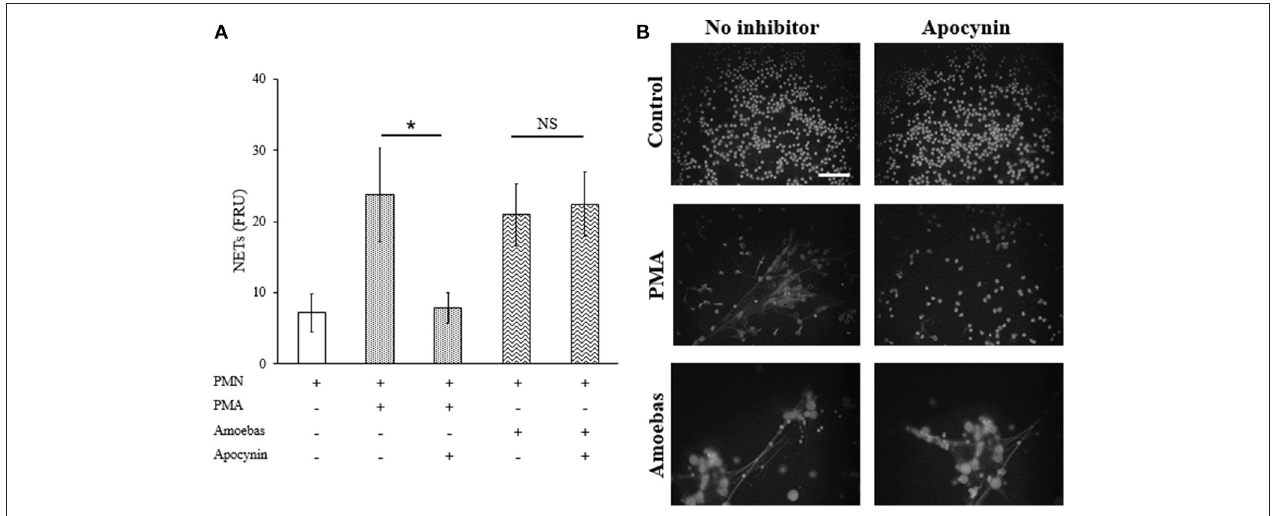
FIGURE 7 | NETosis induced by trophozoites is independent of NOX2-derived ROS. (A) Neutrophils (3 × 10 5 ) were pre-incubated with 200 µ M apocynin or DMSO for 30min and then stimulated with 20nM PMA or co-cultured with trophozoites (1.5 × 10 4 ) during 4h. Supernatants were collected, mixed 1:1 with SYTOX Green (500nM) and fluorescence was measured. NETs amount is expressed in fluorescence relative units (FRU). Values are means ± SD of three independent experiments in triplicate. * p < 0.001; NS: statistically non-significant. (B) Neutrophils were treated as describe previously, cells were fixed and stained with DAPI. Images were taken at 60x magnification. Scale bar 50 µ m.